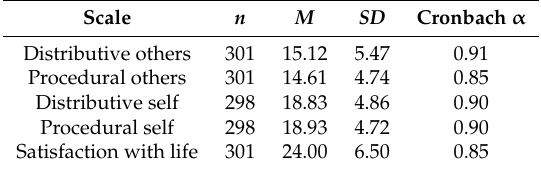
Table 1. Descriptive statistics and internal consistency reliability of the scales used in the